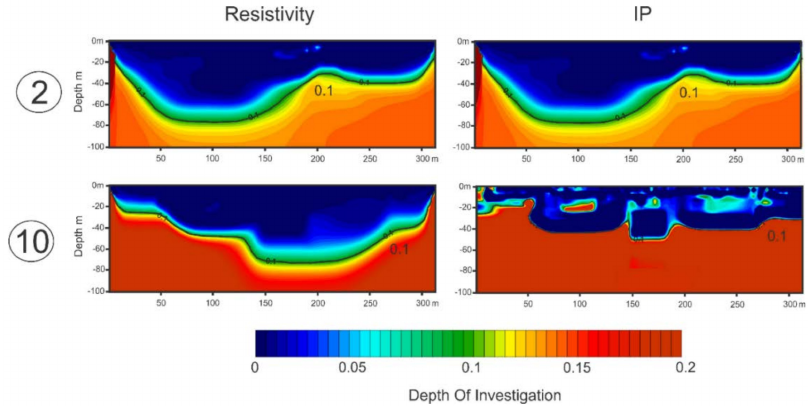
Figure 5. Depth of investigation (DOI) models for electrical resistivity tomography (ERT) and IP data after processing for Profiles 2 and 10. High reliability areas have DOI lower than 0.1.